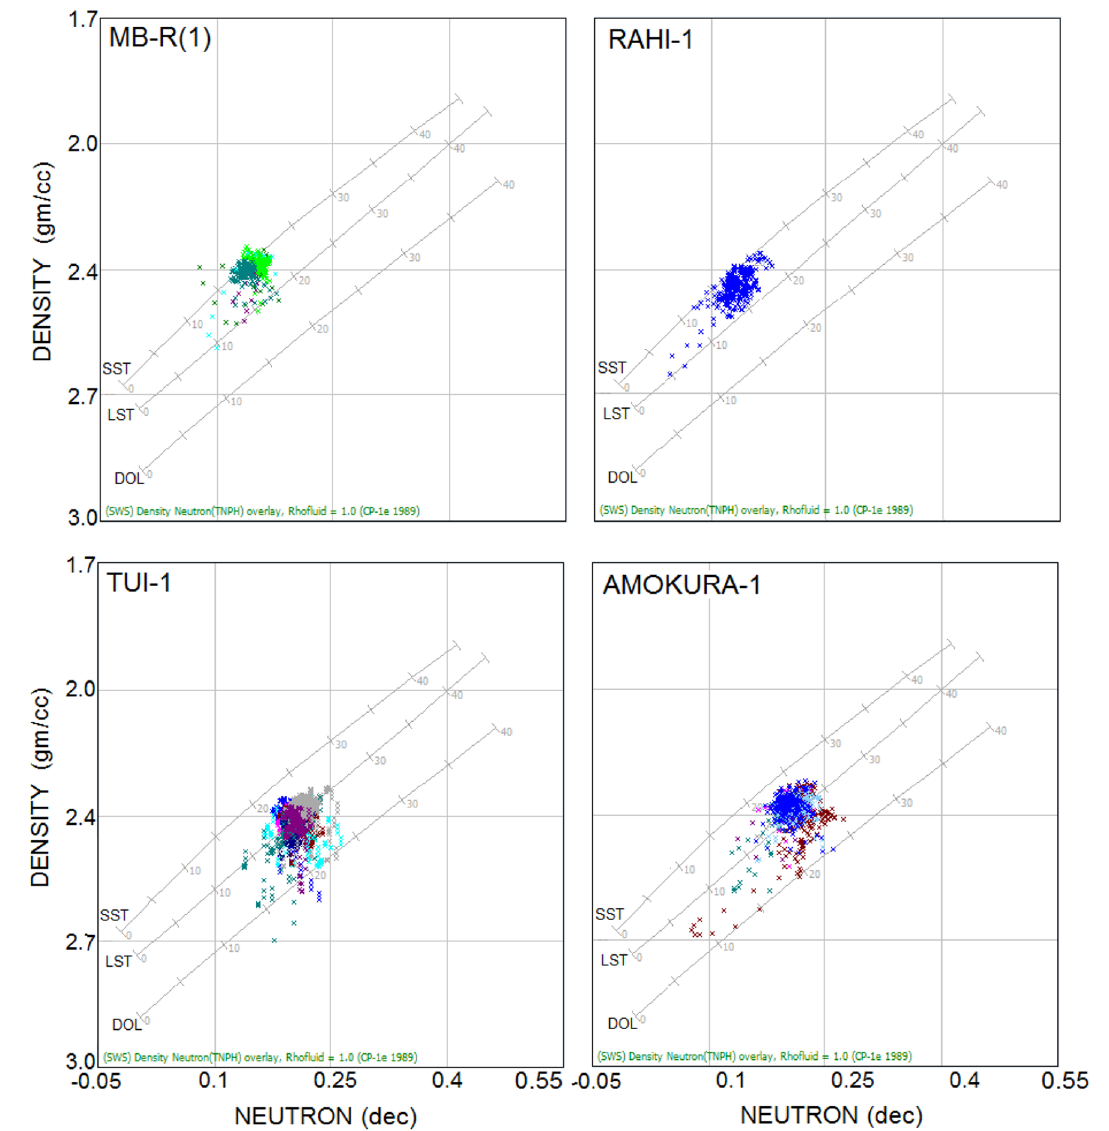
Fig. 10 Lithology analyses of the reservoir zones in the Farewell Formation from the four respective wells based on neutron–density cross-plots Table 1 Well log petrophysical report of Farewell